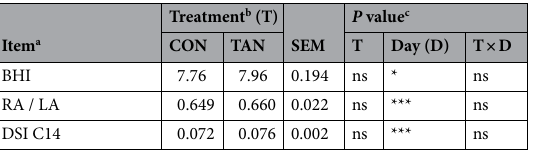
Table 3. Effect of dietary tannin extract on fatty acid profile of milk in wet season experiment. a De novo FA < 16C sum of C4:0, C6:0, C8:0, C10:0, C12:0 and C14:0, SFA saturated fatty acids, MUFA monounsaturated fatty acids, PUFA polyunsaturated fatty acids, OCFA odd-chain fatty acids, BCFA branched-chain fatty acids, BHI biohydrogenation intermediates, DSI C14 desaturation index, calculated as C14:1 c 9/(C14:0 + C14:1 c 9). b CON control group, TAN group receiving 150 g/head × day of tannin extract. c ns ≥ 0.100; † < 0.100; *< 0.050; **< 0.010; ***< 0.001.